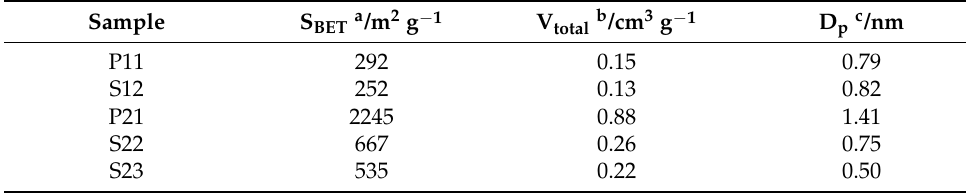
Figure 2. The results of the N 2 adsorption analysis: ( a ) Nitrogen adsorption isotherms of the ground fibers; ( b ) PSD of the carbonized fibers derived from the nitrogen adsorption isotherms by NLDFT; ( c ) PSD of the carbonized and activated fibers derived from the nitrogen adsorption isotherms by NLDFT. Table 2. The results of the analysis of N 2 adsorption.